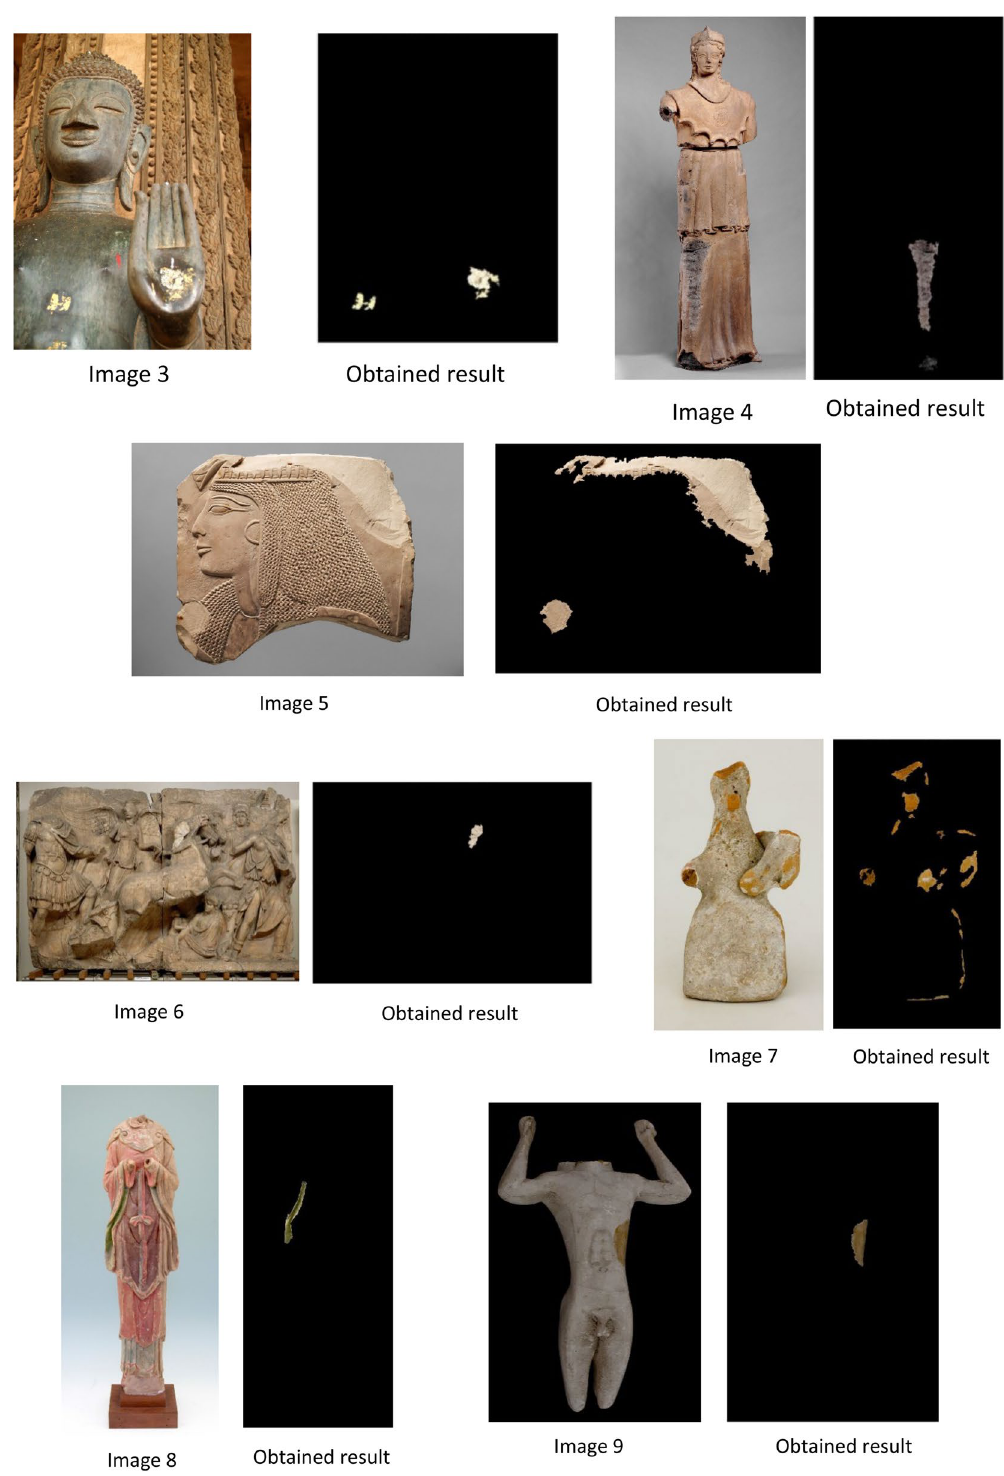
Figure 7. Shows the images used and the output of applying MCAE